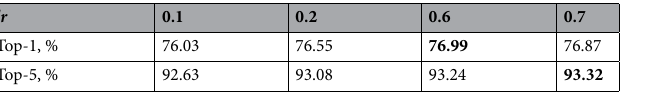
Table 3. Top accuracies for Imagenet classification with Efficientnet-B0 optimized with Coolmomentum at different learning rates. The best values are in bold.